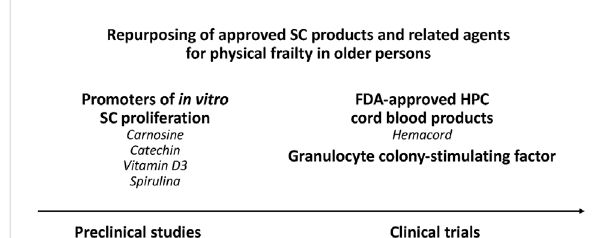
FIGURE 4 Repurposing of approved SC products and related agents